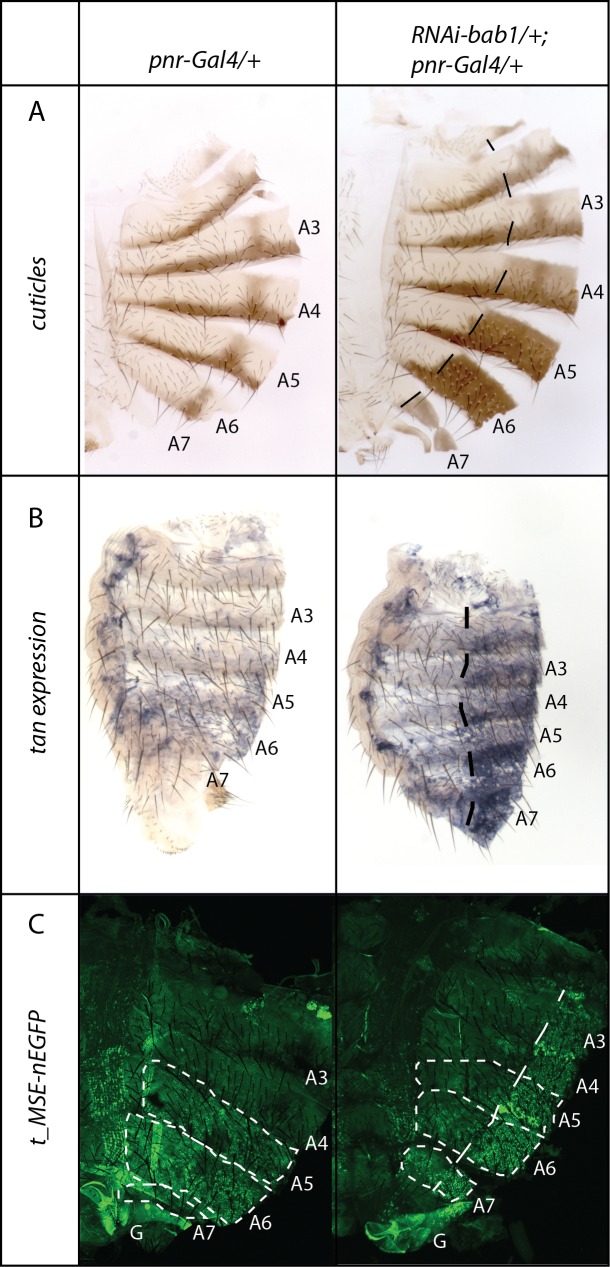
Down-regulation of bab1 in the abdominal epidermis increases t expression and t_MSE abdominal enhancer activity.A: Adult cuticles of control female (left) and female in which bab1 was down-regulated using a UAS-RNAi bab1 transgene and the pnr-Gal4 driver (right). bab1 down-regulation induces an increase of melanin production in the pnr-Gal4 expression domain. B. In situ hybridization experiments on the same genotypes as A showing t expression in the abdomen of freshly hatched females. Compared to the control (left), bab1 down-regulation (right) increases t expression in the pnr-Gal4 expression domain. C. Effect of bab1 down-regulation on the activity of the t_MSE abdominal enhancer (t_MSE-nEGFP transgenic line). Compared to the control (left), bab1 down-regulation in the pnr-Gal4 expression domain induces an increase of nEGFP expression driven by the t abdominal enhancer t_MSE (right). G: genitalia.In A and B, crosses were performed at 29°C to maximize the difference of pigmentation between the dorsal region and the control lateral region. In C, crosses were performed at 25°C. In A, B and C, the dashed lines mark the limit between the dorsal stripe (on the right) in which pnr-Gal4 is expressed and the lateral region (on the left) used as an internal control.